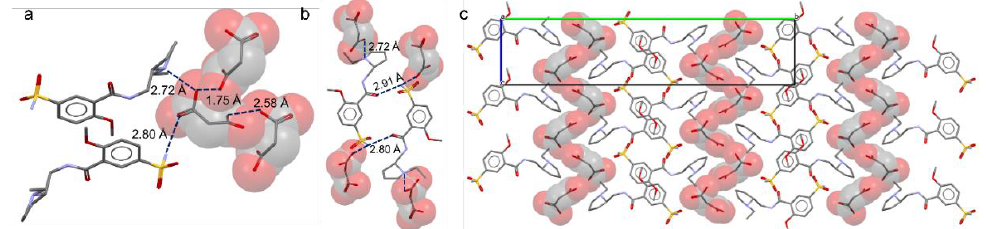
Figure 5. ( a ) Intermolecular interactions established between malonate moiety and surrounding SULP molecules (dashed blue lines). ( b ) Homomeric interactions between SULP dimers are also reported. ESDs are omitted for the sake of clarity. ( c ) Crystal packing of SULP-MLOA along (101) direction. Color code C = grey, N = blue, O = red, S = yellow. MLOA ions are highlighted with spacefill style shadow. Hydrogen atoms are omitted for the sake of clarity.